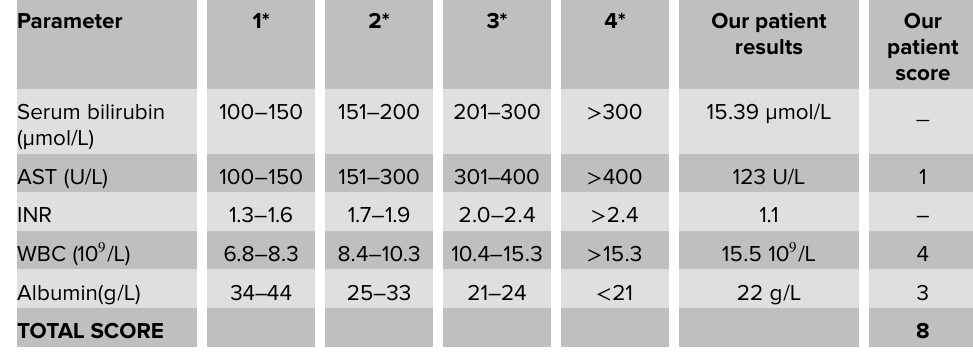
TABLE 3: Prognostic index in Wilson’s